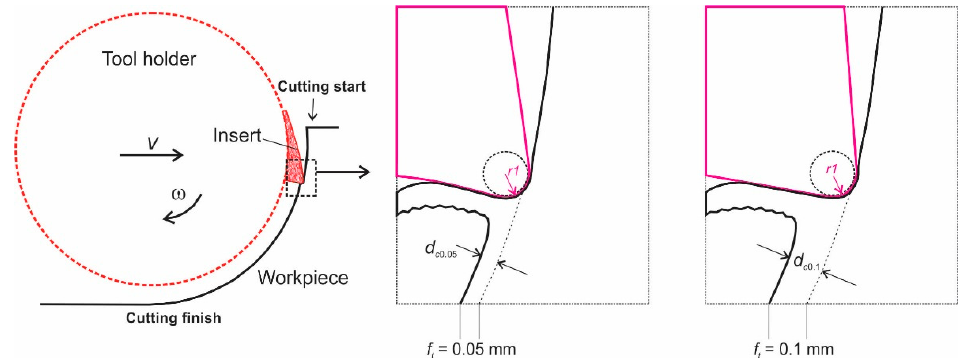
Figure 1. Schematic illustration of milling with two feed rate values: 0.05 mm and 0.1 mm.